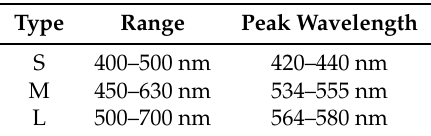
Figure 1. ( a ) An original image from Ishihara plates and the enhanced images using our re-coloring algorithms for protanomaly, deuteranomaly and tritanomaly. ( b ) The images generated from a color vision deficiency simulation tool [6]. The results show that our image enhancement technique is able to improve check pattern recognition under various types of color vision deficiency. Table 1. Cone cells in the human eyes and the response to the light